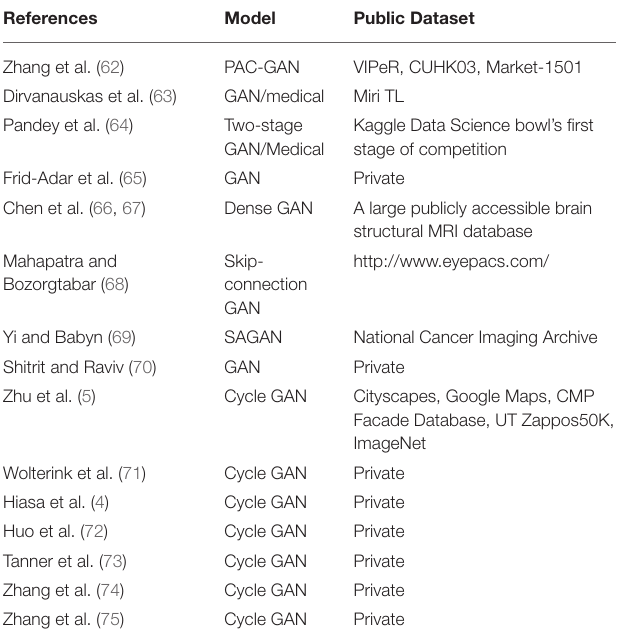
TABLE 2 | Literatures for the application of GAN in medical image processing.